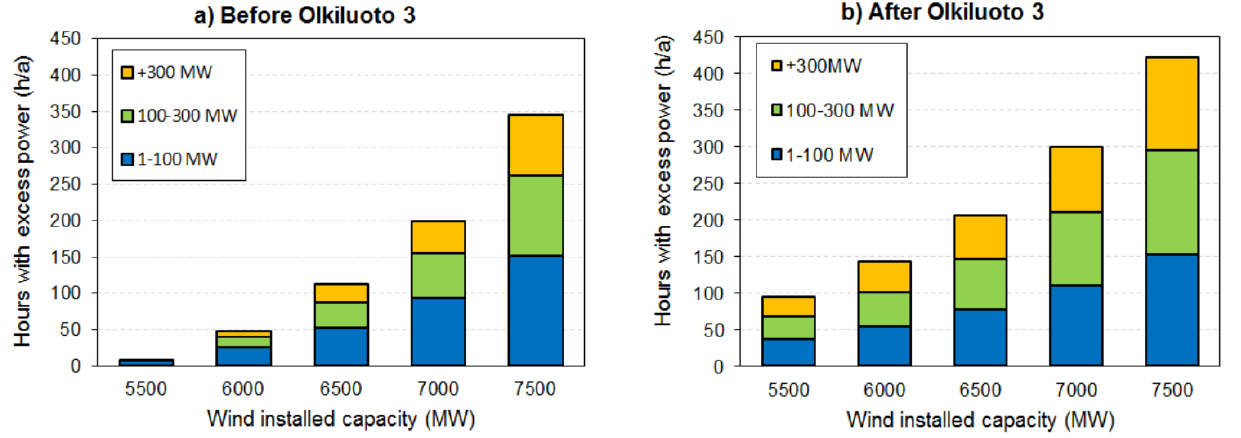
Figure 5. Hours with excess power in different wind integration levels ( a ) before and ( b ) after a nuclear plant with 1600 MW capacity